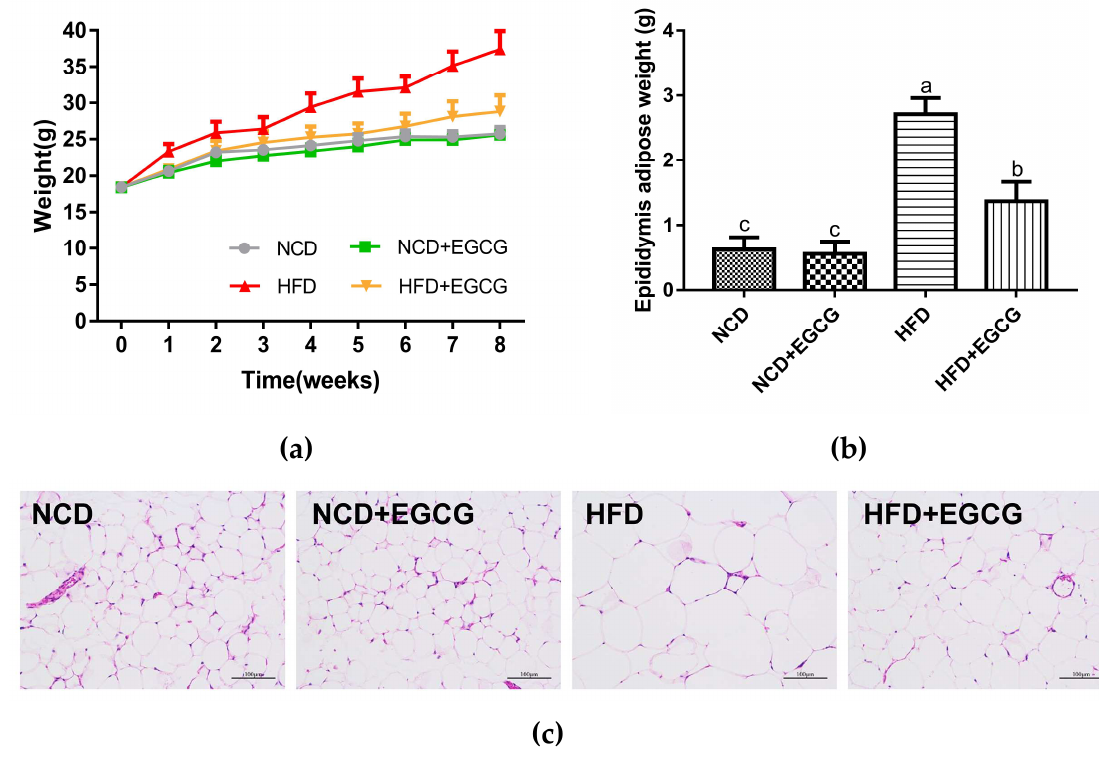
Figure 3. Effect of (−)-epigallocatechin gallate (EGCG) on HFD-induced obesity. ( a ) Weight variation tendency of different groups; ( b ) Weight of epididymis adipose; ( c ) Representative hematoxylin and eosin (H&E) staining of epididymis adipose sections. Data are means ± SEM ( n = 6). Different superscript letters indicate significantly different means at p < 0.05 (a > b > c).